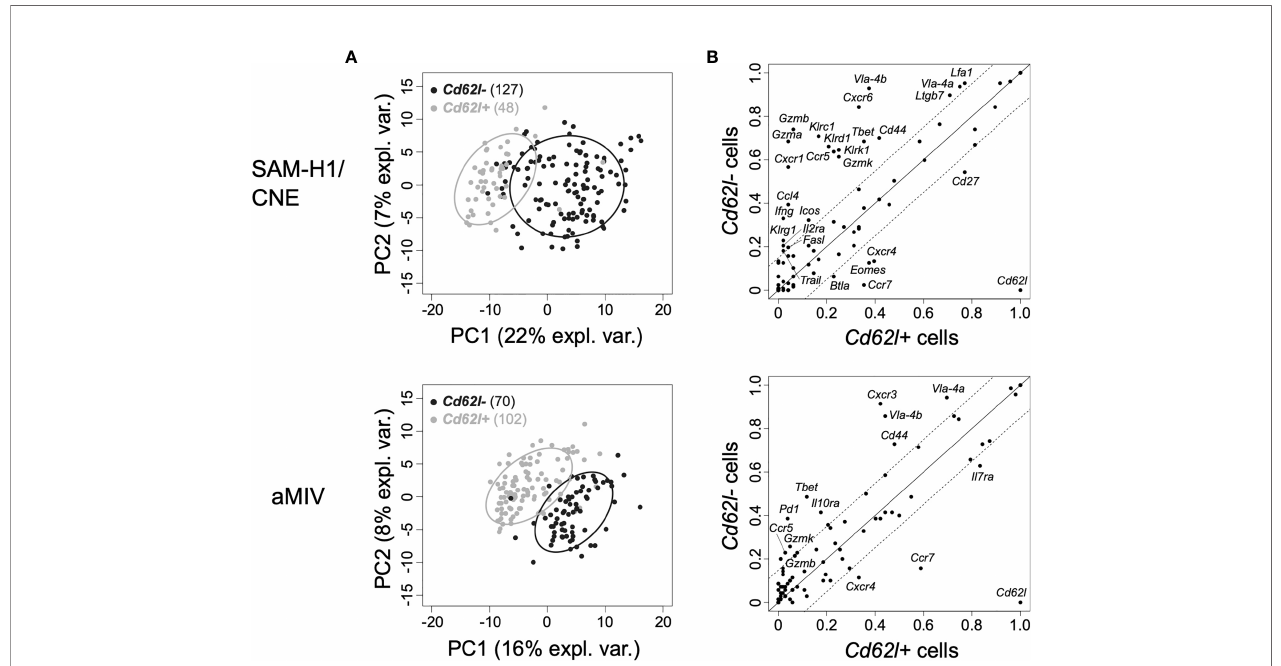
FIGURE 3 | PCA of the transcriptome pro fi les of Cd62l+ and Cd62l- pent+CD8+ T cells at D10P2. (A) Individual Cd62l+ (black) and Cd62l- (grey) pent+CD8+ T cells representation on the fi rst two principal components space for SAM-H1/CNE (top panel) and aMIV (bottom panel) at D10P2. (B) Proportion of Cd62l+ vs Cd62l- pent+CD8+ T cells expressing each individual gene in response to SAM-H1/CNE (top panel) or aMIV (bottom panel). Solid lines indicate equality (y=x), while the area within the dotted lines represents the ±15% tolerance interval ( ≤ 15% difference between Cd62l+ and Cd62l- cell populations).